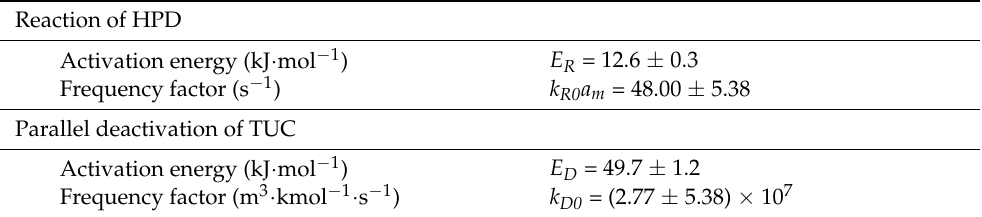
Table 1. Activation energies and frequency factors in Arrhenius equation for reaction and enzyme